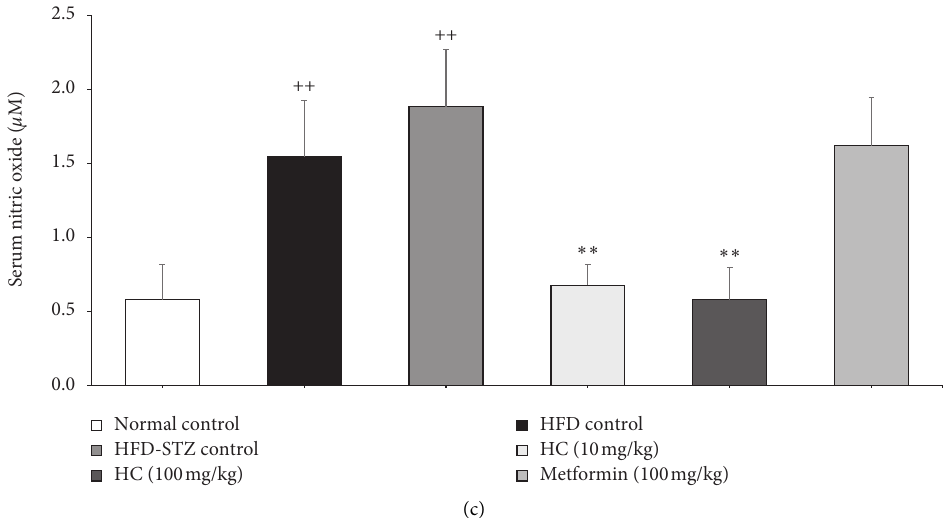
Figure 6: Anti-inflammatory and antioxidant properties of HC in HFD-STZ-induced diabetic rats. (a) Fold change of TNF-α, IL- 1 β, IL- 6 , iNOS, and COX- 2 mRNA level in pancreas tissues of HFD-STZ-treated rats; (b) Serum malondialdehyde (MDA) level; (c) serum nitric oxide. + p < 0 . 01 and ++ p < 0 . 001 versus normal control group. ∗ p < 0 . 01 and ∗∗ p < 0 . 001 versus HFD-STZ control group. Results are presented as means ± SD ( n � 6 each group).